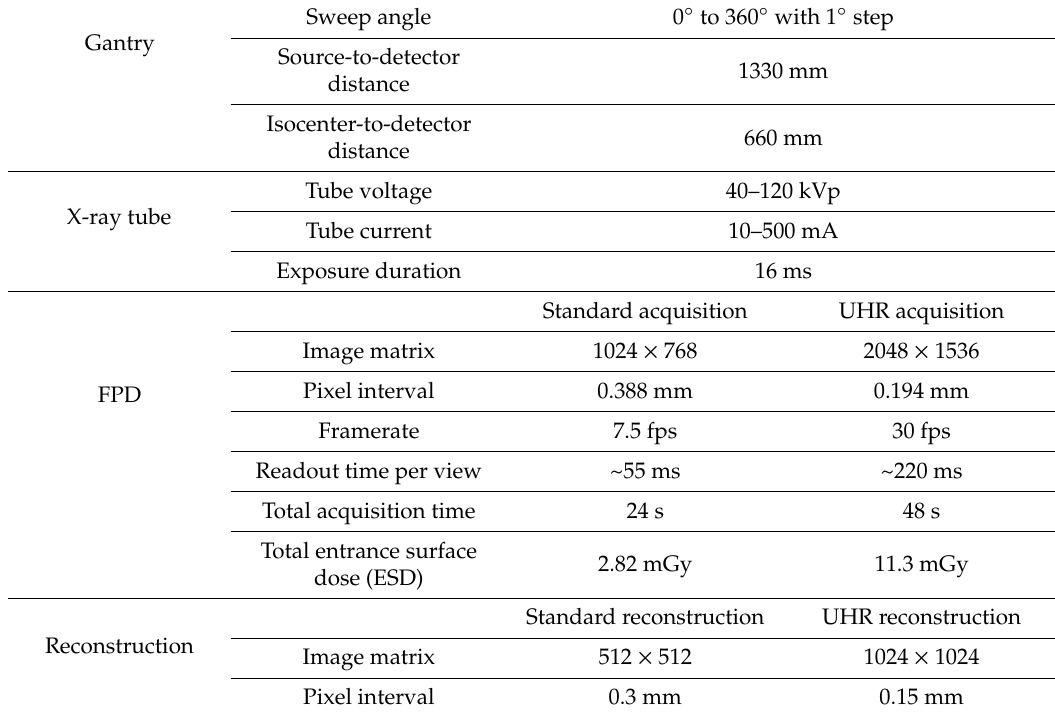
Figure 1. Photograph of the prototype cone-beam computed tomography (CBCT) system capable of both standard and ultra-high resolution (UHR) acquisition. Table 1. Specifications of the imaging conditions.